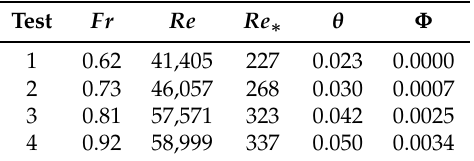
Table 2. Non-dimensional parameters characterizing the mean